Question: Name the type of graph shown.
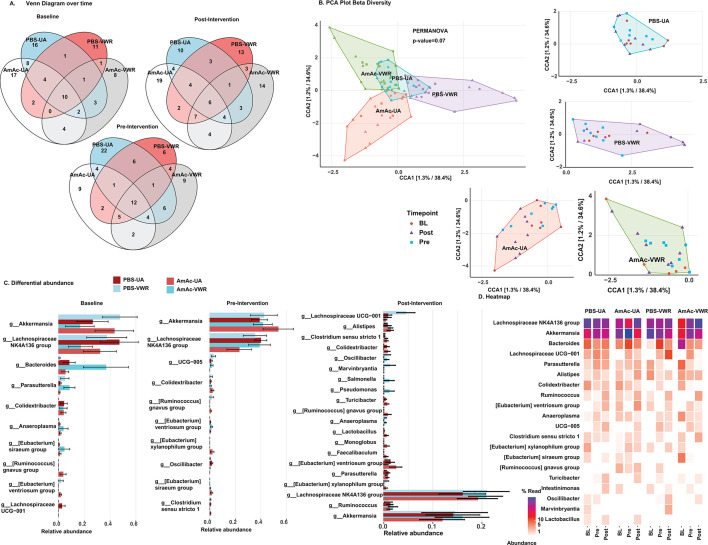
Answer: heatmap